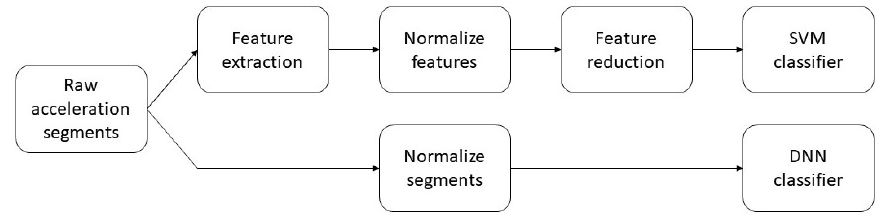
Figure 1. Flowchart showing the difference between handling the acceleration segments when using a feature-based machine learning classifier, in this case a support vector machine (SVM), and a deep neural network